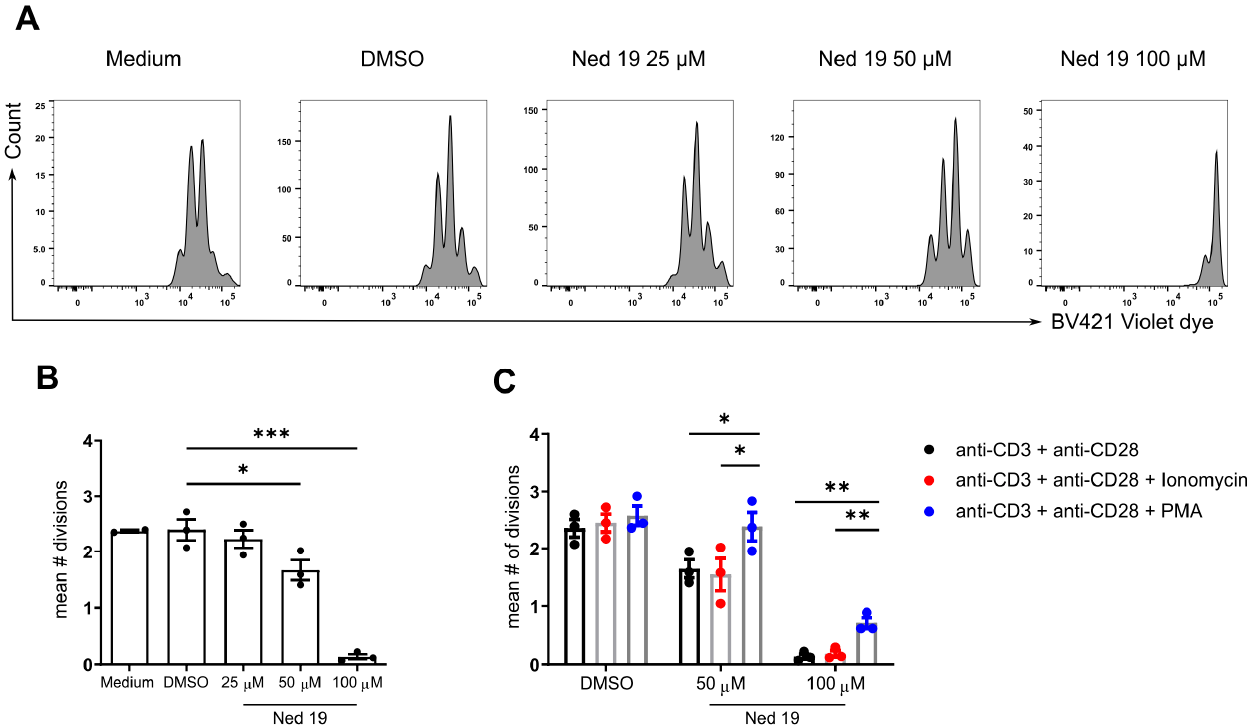
Figure 3. NAADP inhibition by means of trans-Ned 19 impairs naïve CD4 + T cell proliferation upon TCR stimulation which is reversible by PMA. The naïve CD4 + T cells were freshly isolated from WT C57BL/6N mice, loaded with violet dye, incubated with increasing concentrations of trans-Ned 19 for 1 h and stimulated with plate bound anti-CD3 mAb (2 µg/mL) and soluble anti-CD28 mAb (1 µg/mL). ( A ) Representative histograms of violet dye dilution. ( B ) Summary statistics of mean number of divisions indicated by violet dye dilution. ( C ) Summary statistics of proliferation assay with trans-Ned 19 and addition of either ionomycin (200 ng/mL) or PMA (100 ng/mL). Presented data are mean ± SEM. The p -values were calculated with repeated measures ANOVA with Dunnett’s multiple comparison test. * p < 0.05, ** p < 0.01, *** p < 0.005.